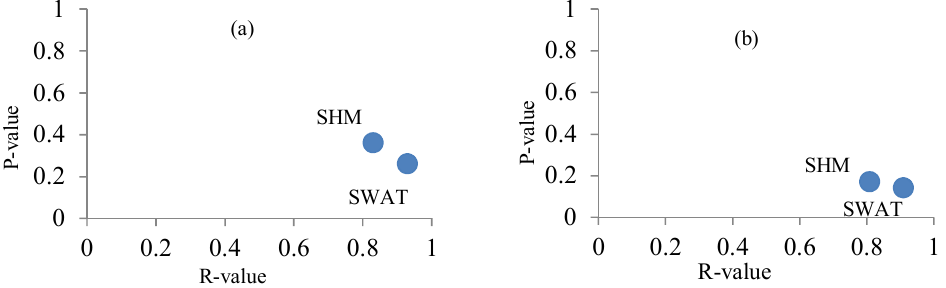
Figure 7. P-value vs. R-value for ( a ) calibration period and ( b ) validation period for the SHM and SWAT model simulations.